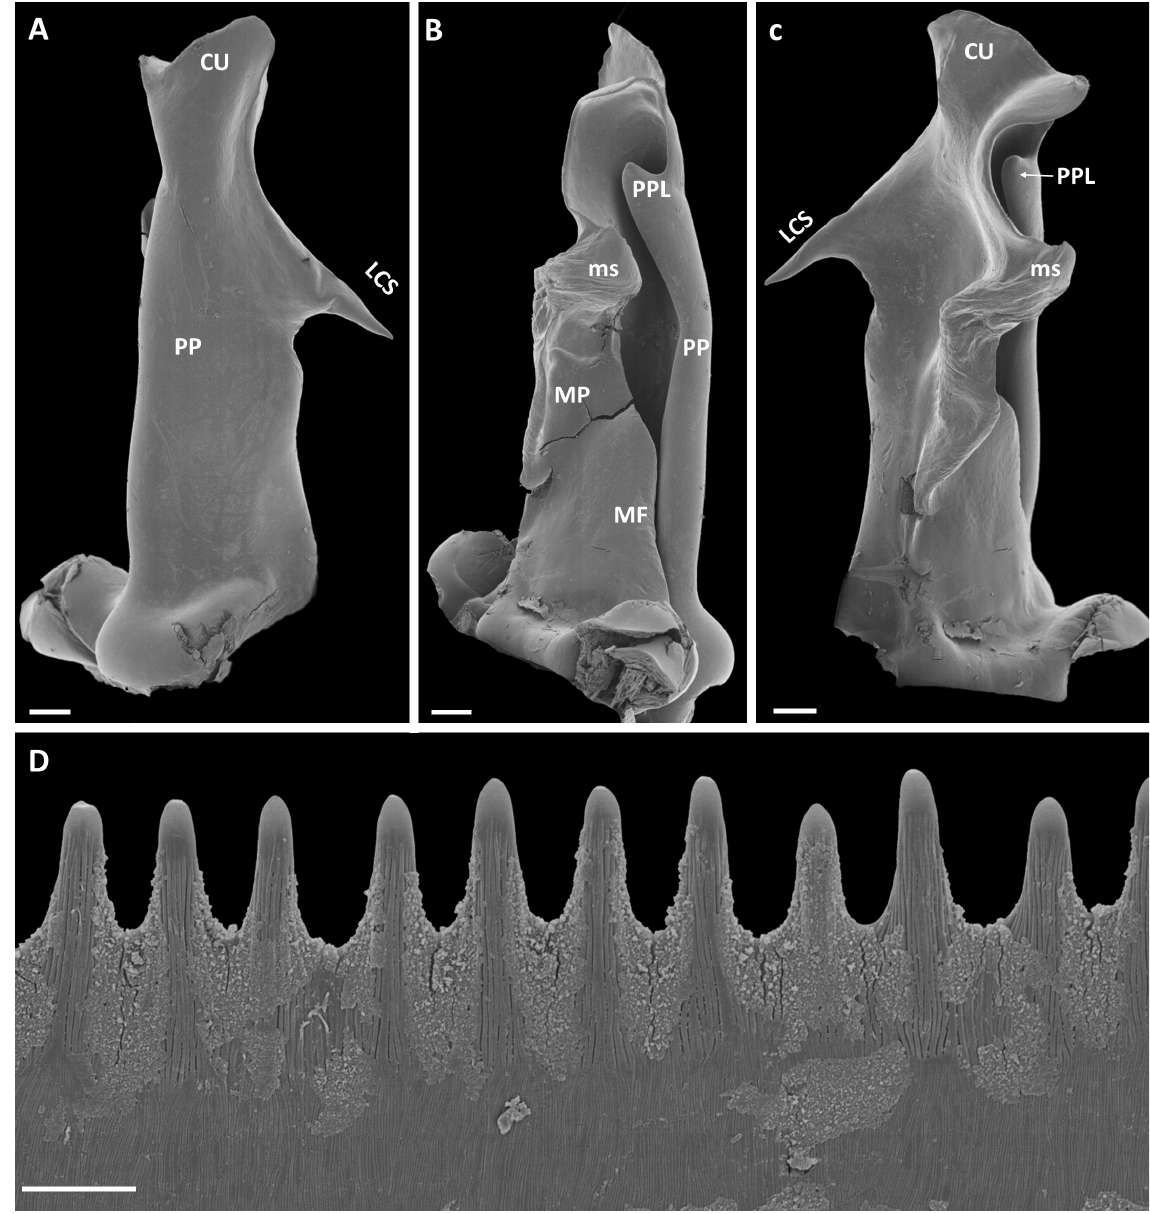
Fig. 32. Chaleponcus sergeii sp. nov., holotype, ♂ (NHMD 621728). A–C . Right gonopod coxa. A. Anterior view. B. Mesal view. C. Posterior view. D . Midbody dorsal limbus. Abbreviations: CU = cucullus; LCS = lateral coxal spine; MP = metaplica; MF = metaplical flange; ms = metaplical shelf; PP = proplica; PPL = proplical lobe. Scale bars: A–C = 0.2 mm; D = 0.01